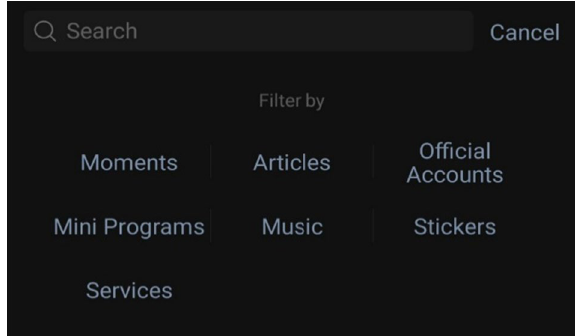
Fig. 7 Upon selecting the search function, users can filter their